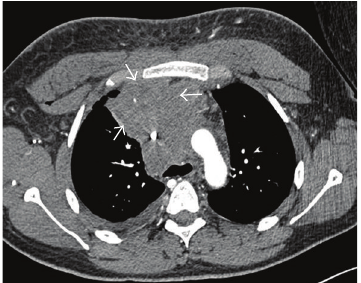
Figure 2: Pretreatment computed tomography of the thorax dem- onstrating a large anterior mediastinal mass (see arrows).